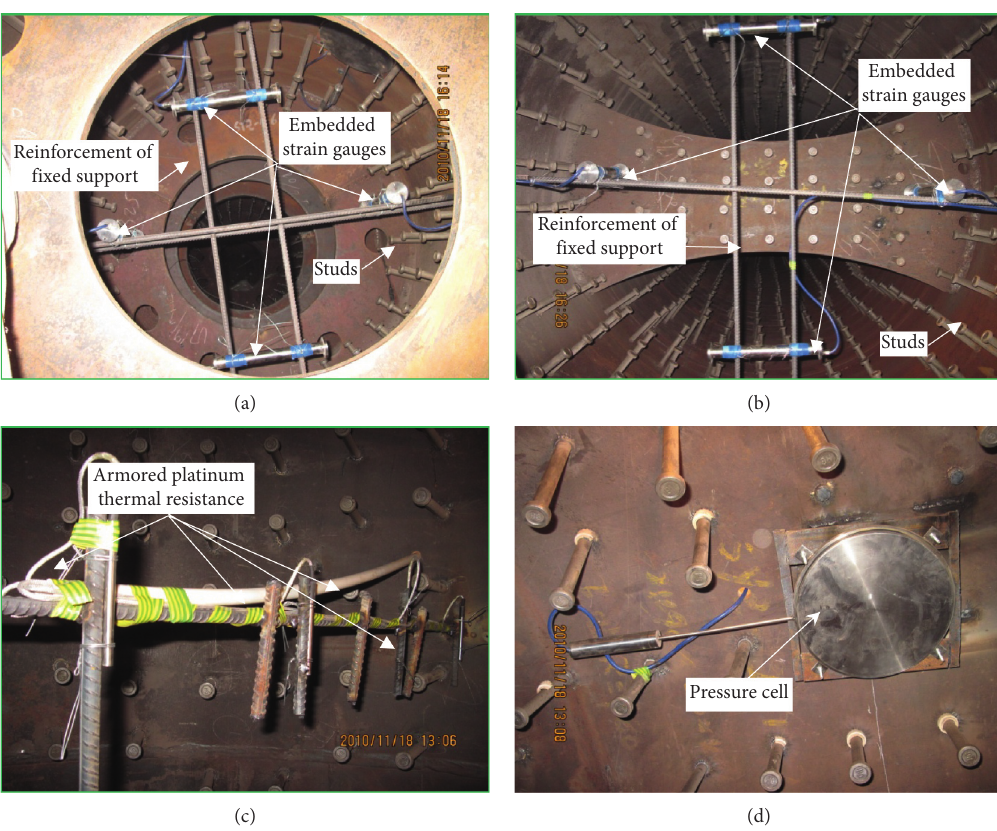
Figure 4: Arrangement photos of test instruments. (a) Deformation measurement of SYZ-1 column. (b) Deformation measurement of SYZ- 2 column. (c) Temperature measurement. (d) Vibrating-wire pressure